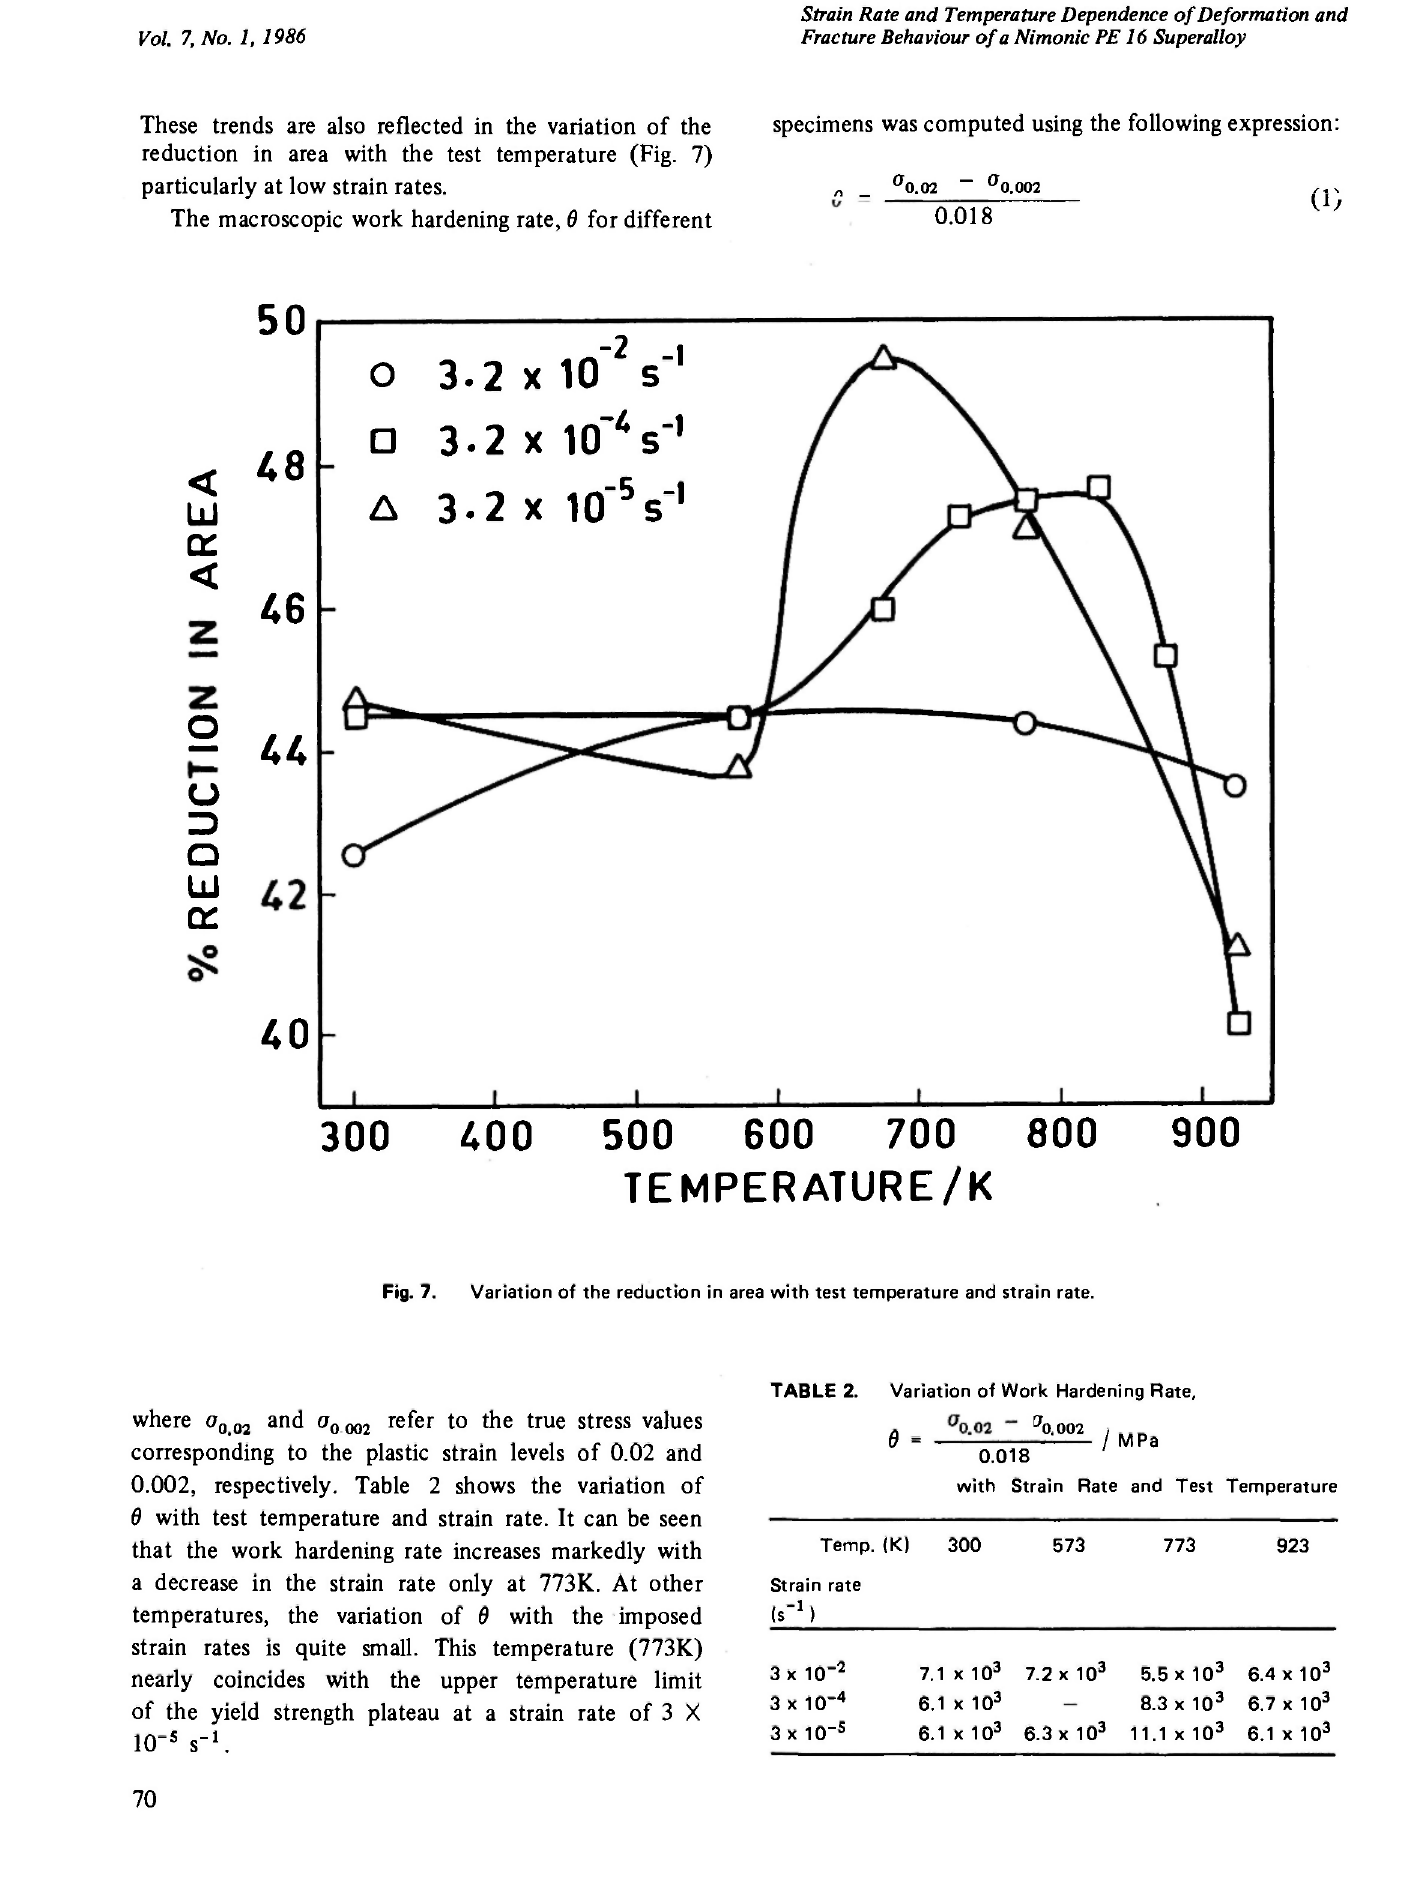
Variation of Work Hardening